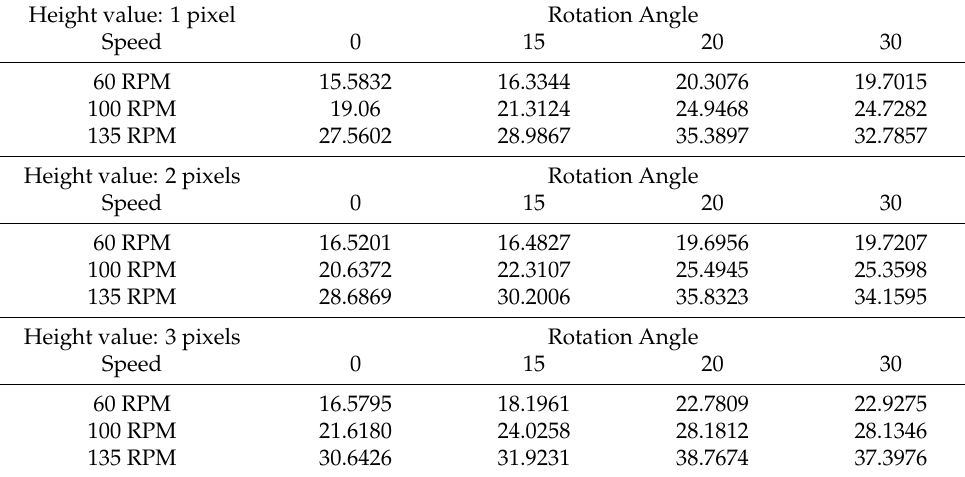
Table 5. Synthetic radial motion blur performance-RMSE (mm).